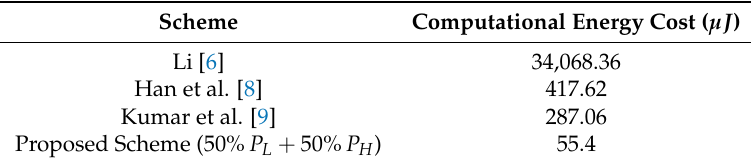
Table 8. Comparison of computational energy